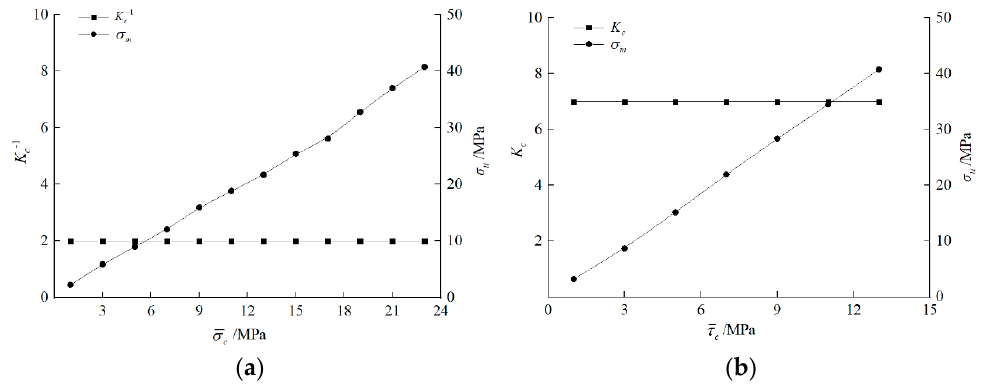
σ and the maximum value of the peak